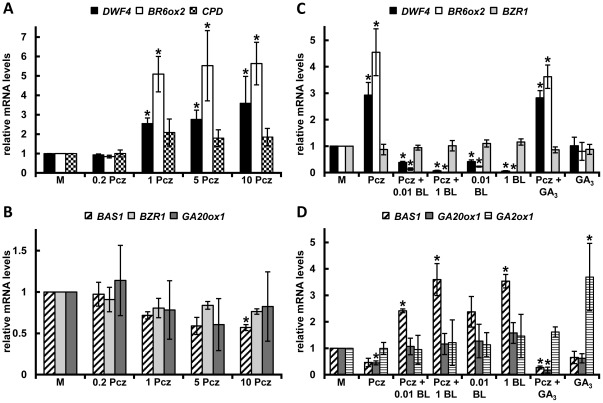
Pcz impact on the expression of BR- and GA-related genes.(A–D) Quantitative real-time PCR analysis of the transcript levels after treatment with 0.2, 1, 5 or 10 µM Pcz of (A) BR biosynthetic genes DWF4, BR6ox2, and CPD or (B) BAS1, BZR1, and GA20ox1, involved in BR degradation, BR signaling and GA biosynthesis, respectively. (C, D) Expression pattern of (C) BR biosynthesis and signaling or (D) BR degradation, GA biosynthesis and GA degradation (GA2ox1) genes measured after treatments with 1.5 µM Pcz, 0.01 or 1 µM BL, or 1 µM GA3 or co-applications of Pcz (1.5 µM) with 0.01 or 1 µM BL or 1 µM GA3. (A–D) Data points represent the average of three independent biological replicates with three technical replicates each. Error bars represent standard deviation. Asterisks indicate significant differences to the respective mock determined by Student's t-test (p<0.05). Ubiquitin conjugating enzyme 21 (UBC21) was used as internal control.